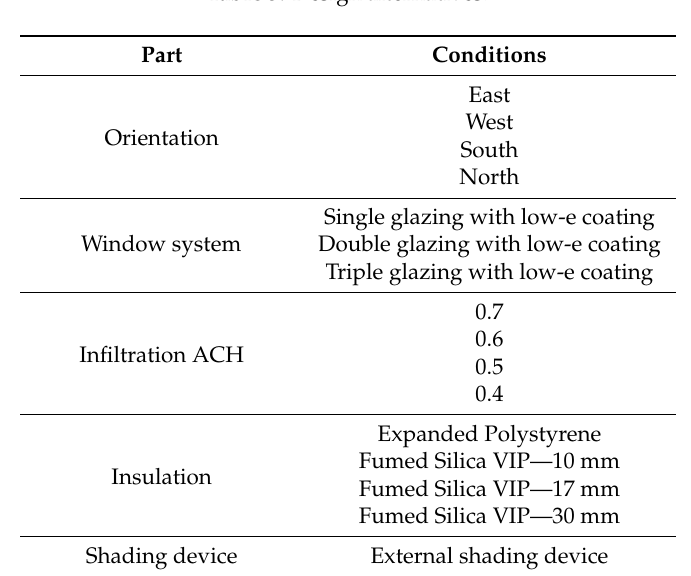
Table 3. Design alternatives.